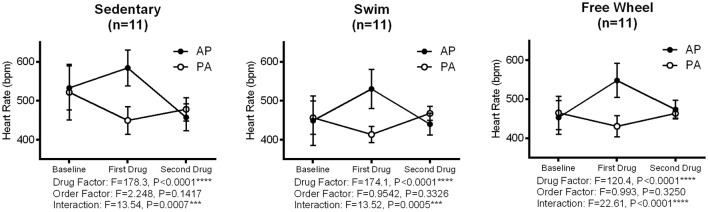
Influence of sequential administration of atropine and propranolol, and drug order effects, on heart changes in sedentary and exercised mice. Representative changes in HR following sequential administration of atropine (A) (2 mg/kg) and propranolol (P) (10 mg/kg) in two opposite orders (i.e., AP and PA) are shown. Two-way ANOVA indicated a significant main effect for drug (P < 0.0001, all groups) and interaction between drug and order (P < 0.0007 in all groups), with no effect of order observed (P > 0.14, all groups). In all groups, atropine had a larger effect (i.e., 1.5-to-2-fold) (P < 0.0001) on HR increase when administered in the absence compared to the presence of propranolol. In contrast, propranolol had a larger effect (i.e., 1.5-to-2-fold) (P < 0.0001) on HR when administered after atropine. These results are indicative of “accentuated antagonism.” Solid circles (•) indicate the atropine-propranolol (AP) sequence, while open circles (°) indicate the propranolol-atropine (PA) sequence. Data are given as means ± SD.